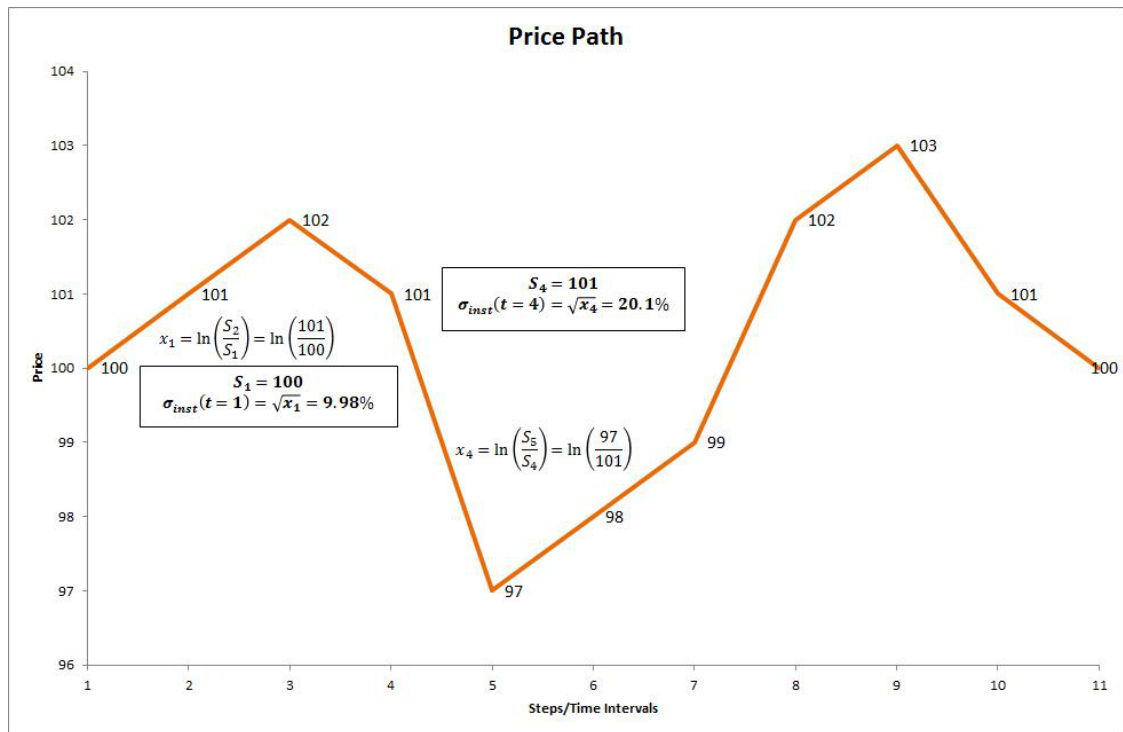
Figure 1. Price path of some stock showing the standard deviation, annualized volatility and instantaneous